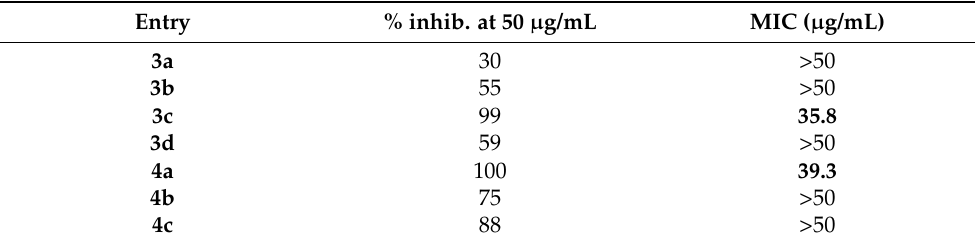
Table 6. Percentage of inhibition at 50 µ g/mL concentration and MIC values ( µ g/mL) in the MABA test for compounds 3a – d and 4a – c . These values are the result of the average of two independent experiments; bold data evidence promising antibacterial